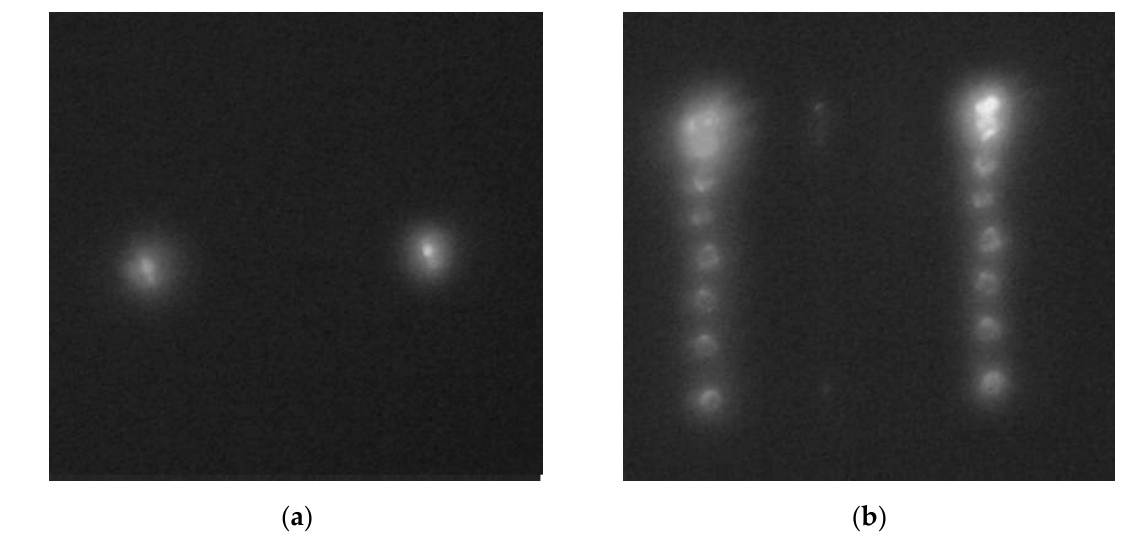
Figure 9. SDL-aided diffraction orders imaged on the matrix for wavelengths of 900 nm and 970 nm from ( a ) a single source and ( b ) a group of linearly arranged ~1-mm sources.